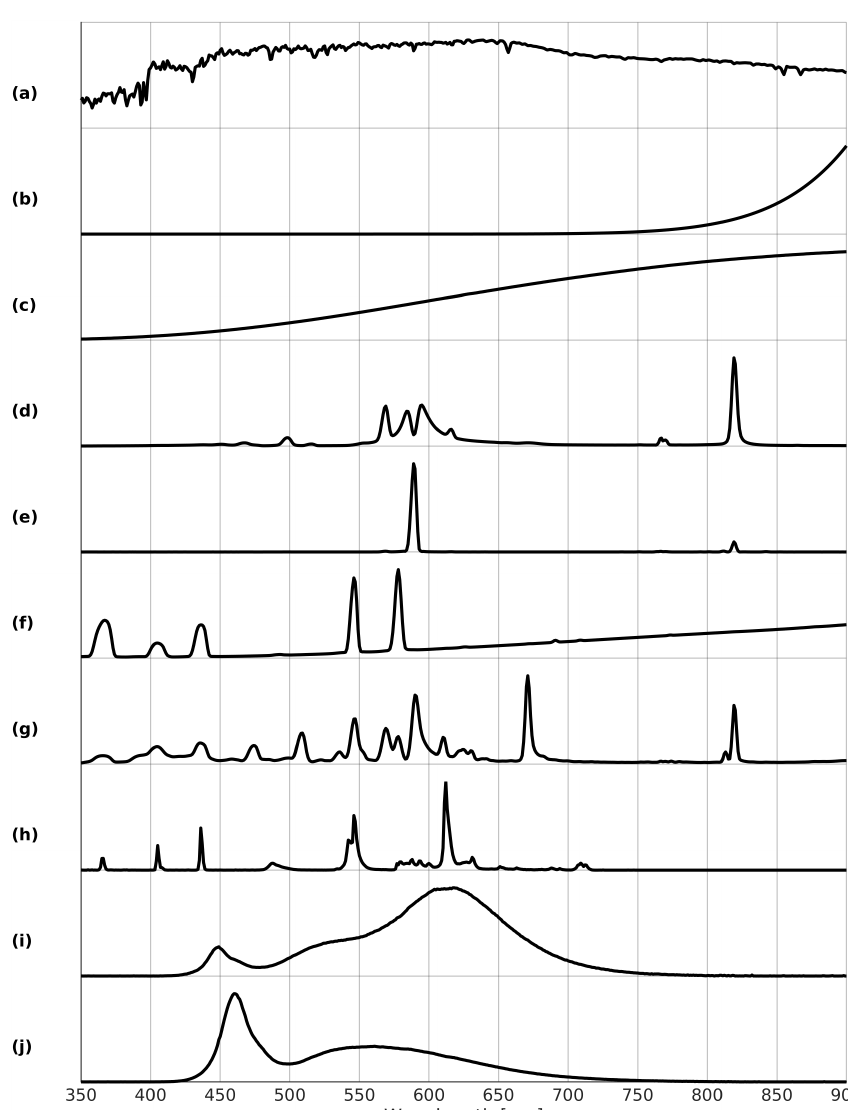
Figure 2. Typical normalized emission spectra by NOAA [17] and GUAIX [20] for different nighttime radiation sources (stacked offset for clarity): ( a ) cloud-free full moon; ( b ) fire, 700K; ( c ) incandescent lamp; ( d ) high-pressure sodium lamp; ( e ) low-pressure sodium lamp; ( f ) mercury vapor lamp; ( g ) metal halide lamp; ( h ) fluorescent lamp; ( i ) warm-white LED lamp; ( j ) cold-white LED